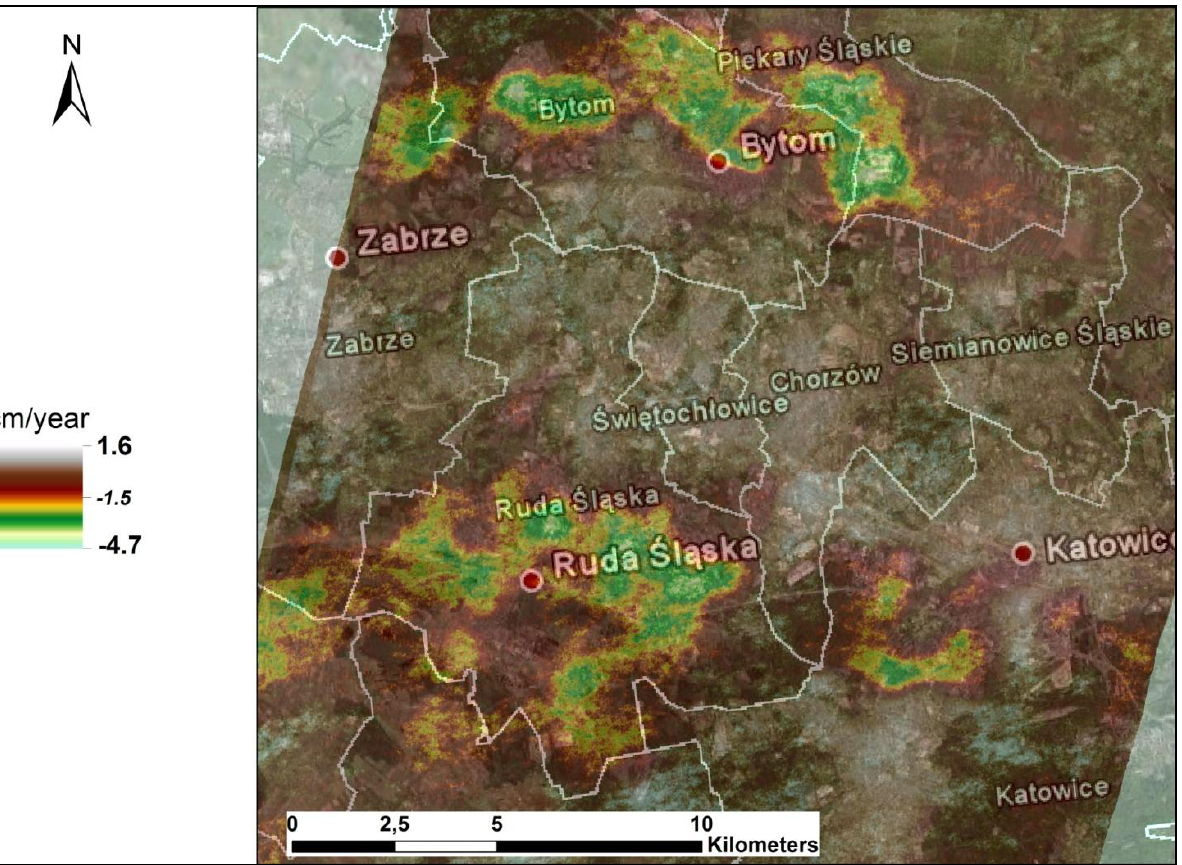
Fig.7. Stacked ERS1-2 images where the detected subsidence is related to coal mining zones during the period 21.05.1993–15.11.2000. The values are representative; the map mostly serves only to introduce the most subsided